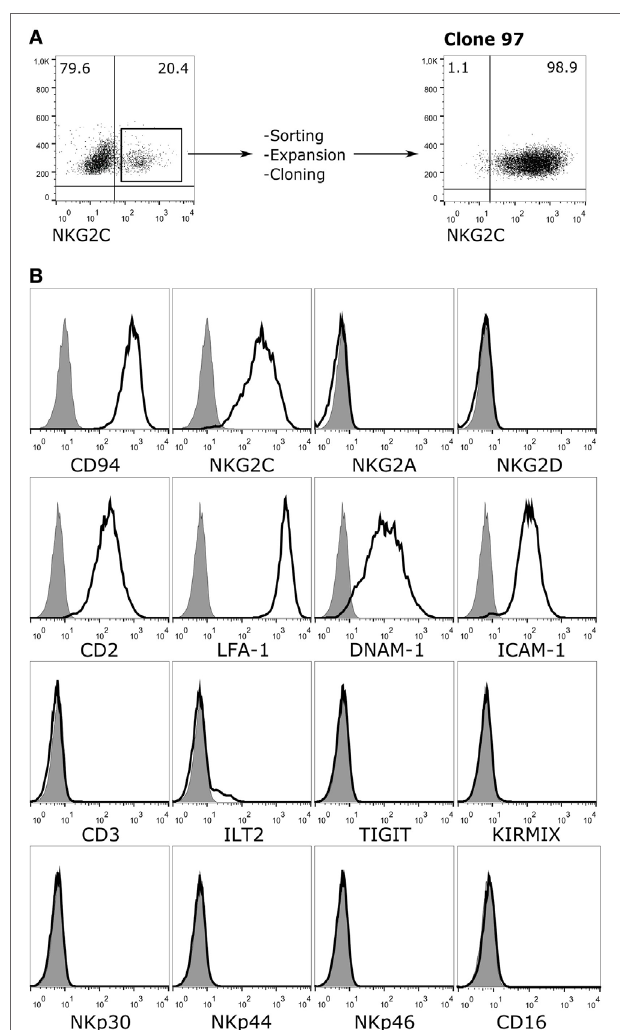
FigUre 1 | Phenotypic characterization of Jurkat-NKG2C + reporter cells. (a) Jurkat-CD94 + cells were transduced with retroviral particles carrying the sequences encoding for NKG2C and DAP12 as described in Section “Materials and Methods.” After sorting, expansion, and limiting dilution, clone 97, which expressed high levels of the CD94/NKG2C heterodimer was selected. (B) Jurkat-NKG2C + cells were stained for the indicated receptors and analyzed by flow cytometry. KIRMIX corresponds to a mixture of the following monoclonal antibodies: HP-MA4 (KIR2DL1/2DS1/2DS3/2DS5), CHL (KIR2DL2/2DL3/2DS2), 5.133 (KIR3DL1/3DL2/2DS4/2DS5/2DS2/3DS1), DX9 (KIR3DL1), UP-R1 (KIR2DL5). Gray histograms correspond to the isotype